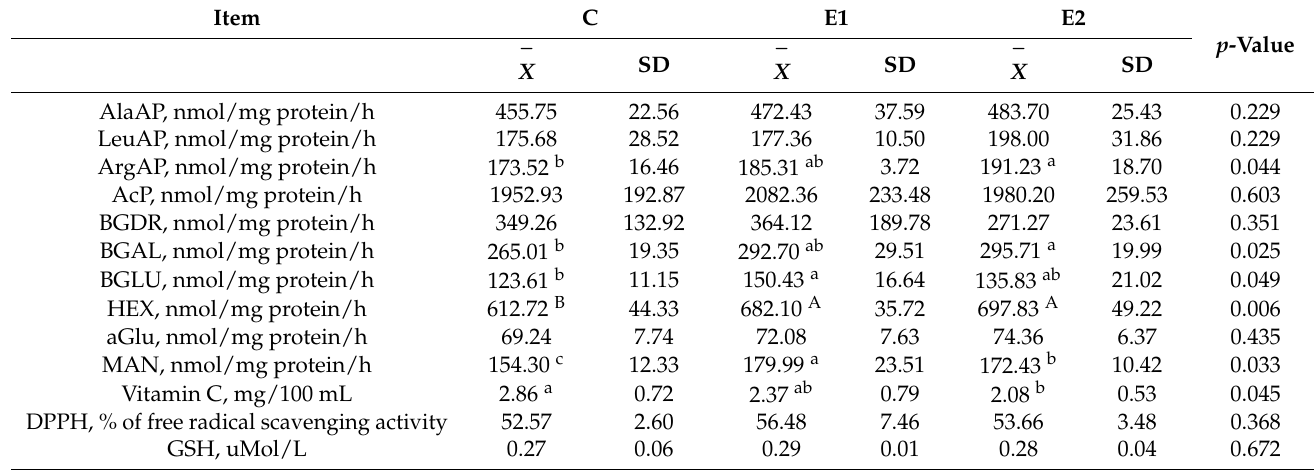
Table 5. Selected enzyme activity and antioxidant potential for chosen substances in the breast muscles of broilers ( n =